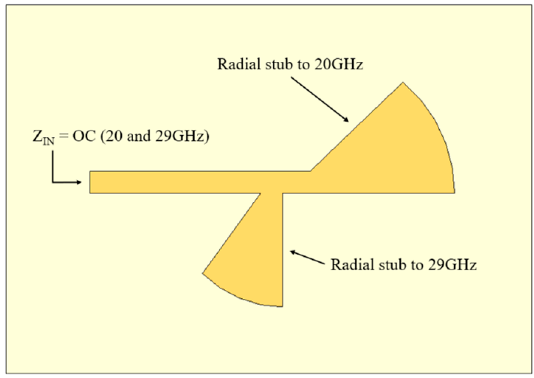
Figure 4. Designed structure of the dual frequency bias circuit to the PIN diodes.